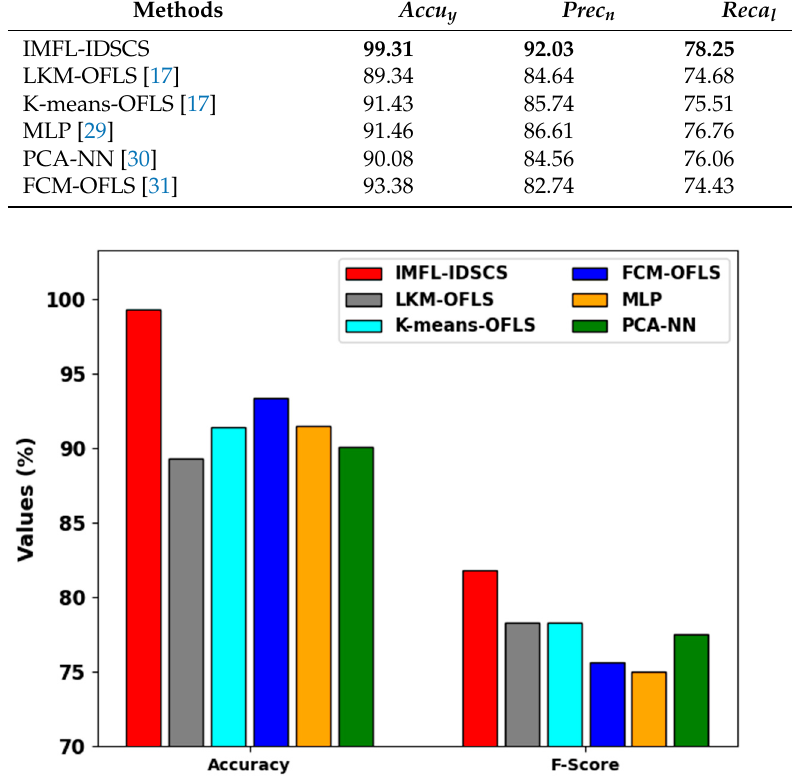
Figure 10. Accu y and F score analysis of IMFL-IDSCS system with other Figure 10. 𝐴𝑐𝑐𝑢 (cid:3052) and 𝐹 (cid:3046)(cid:3030)(cid:3042)(cid:3045)(cid:3032) analysis of IMFL-IDSCS system with other approaches.